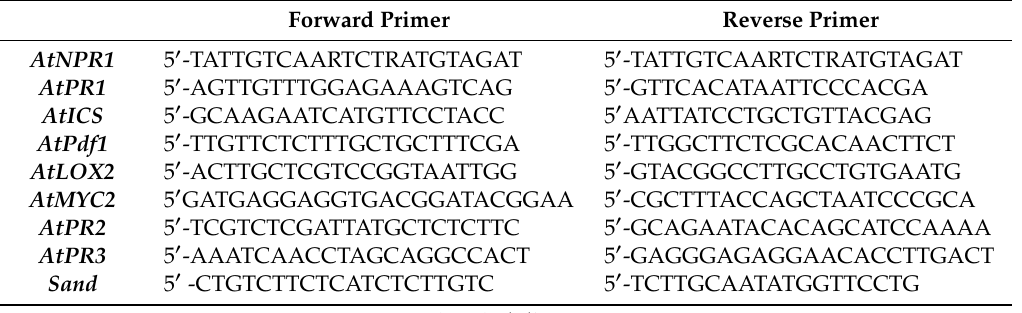
Table 5. Forward and reverse primers used in qPCR